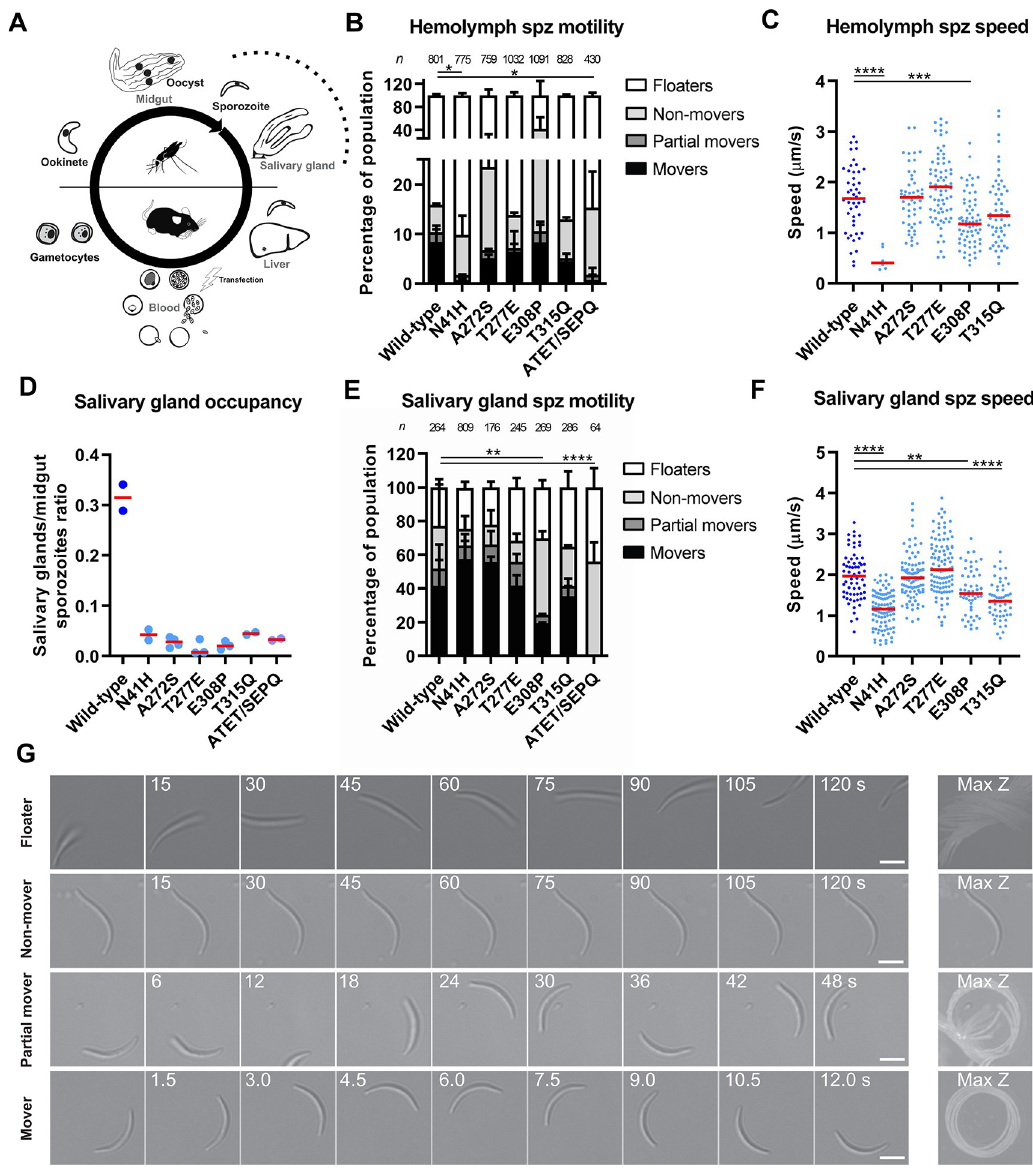
Fig 3. Actin mutants are highly deficient in salivary gland invasion. (A) Schematic representation of the Plasmodium life cycle with late mosquito stages indicated with a dashed line. Sporozoites egress from oocysts and, after passive transport through the mosquito hemolymph, penetrate salivary glands. (B) Hemolymph sporozoite motility was analysed using a 2D motility assay. Consistent with the effect of ATET/SEPQ on ookinete motility, this mutant was highly deficient in motility. Subdomain 2 mutant N41H also displayed a highly reduced motile population while single subdomain 3 mutants were motile at similar level to wild- type controls. Bars represented as mean ± standard deviation for repeats between at least two independent mosquito infections (with exception of N41H, standard deviation of two technical repeats across two days from single infection). Fischer’s exact test, � p < 0.05. (C) Speeds of moving hemolymph sporozoites were similar between mutants, with the exception of N41H which was slower. E308P was also slower but was in the normal median range for wild-type speeds. ATET/SEPQ is absent since only two motile sporozoites were observed in this assay. Red line indicates median value. Mann-Whitney test, ��� p = 0.0002, ���� p < 0.0001. (D) All actin mutants displayed an approximately 10-fold reduction of salivary gland sporozoite numbers when normalized to midgut sporozoite loads of the same mosquitoes. Red line indicates median value of repeats of d19 counts of least two independent mosquito infections per line. (E) Single mutant salivary gland sporozoites generally had a similar proportion of motile parasites while E308P had a slight reduction and ATET/SEPQ had zero movers. Bars represented as mean ± standard deviation for repeats between at least two independent mosquito infections. Fischer’s exact test, �� p < 0.01, ���� p < 0.0001. N41H displayed a slightly elevated motile population (p = 0.03) but this is in the normal range for wild-type parasites. (F) Subdomain 3 mutant salivary gland sporozoites had similar speeds when compared to the wild-type control. N41H, E308P and T315Q